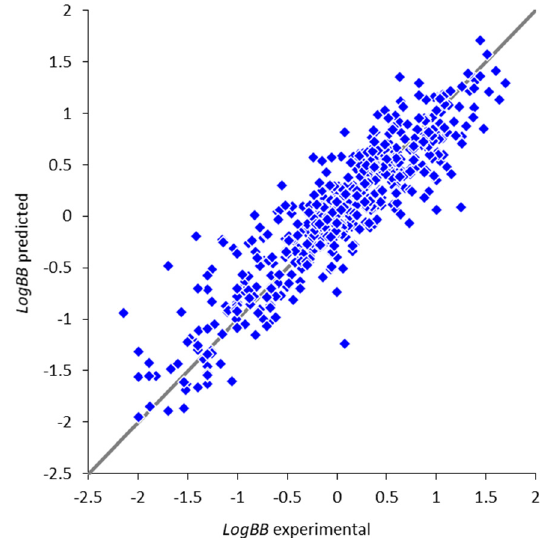
Figure 3. Comparison of the experimental LogBB values and the values predicted during double cross-